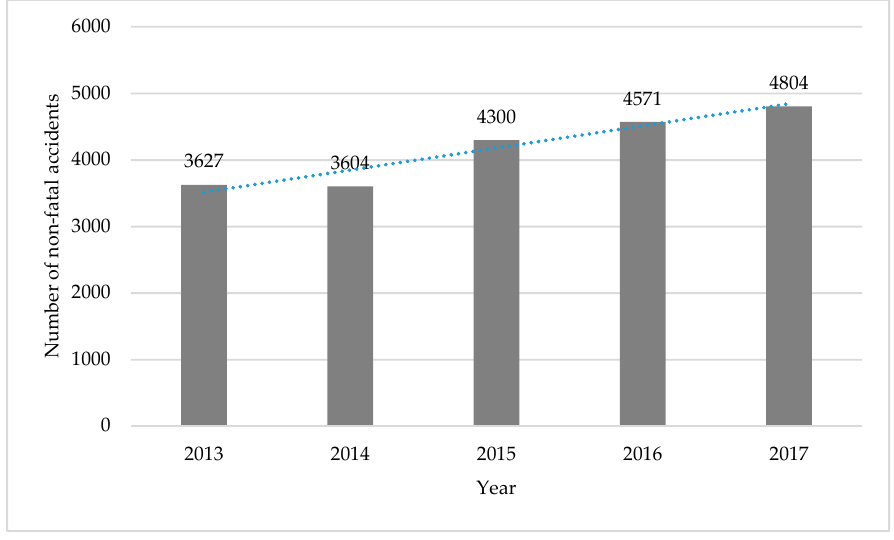
Figure 8. The situation of non-fatal accidents in Romania during 2013–2017 [2].